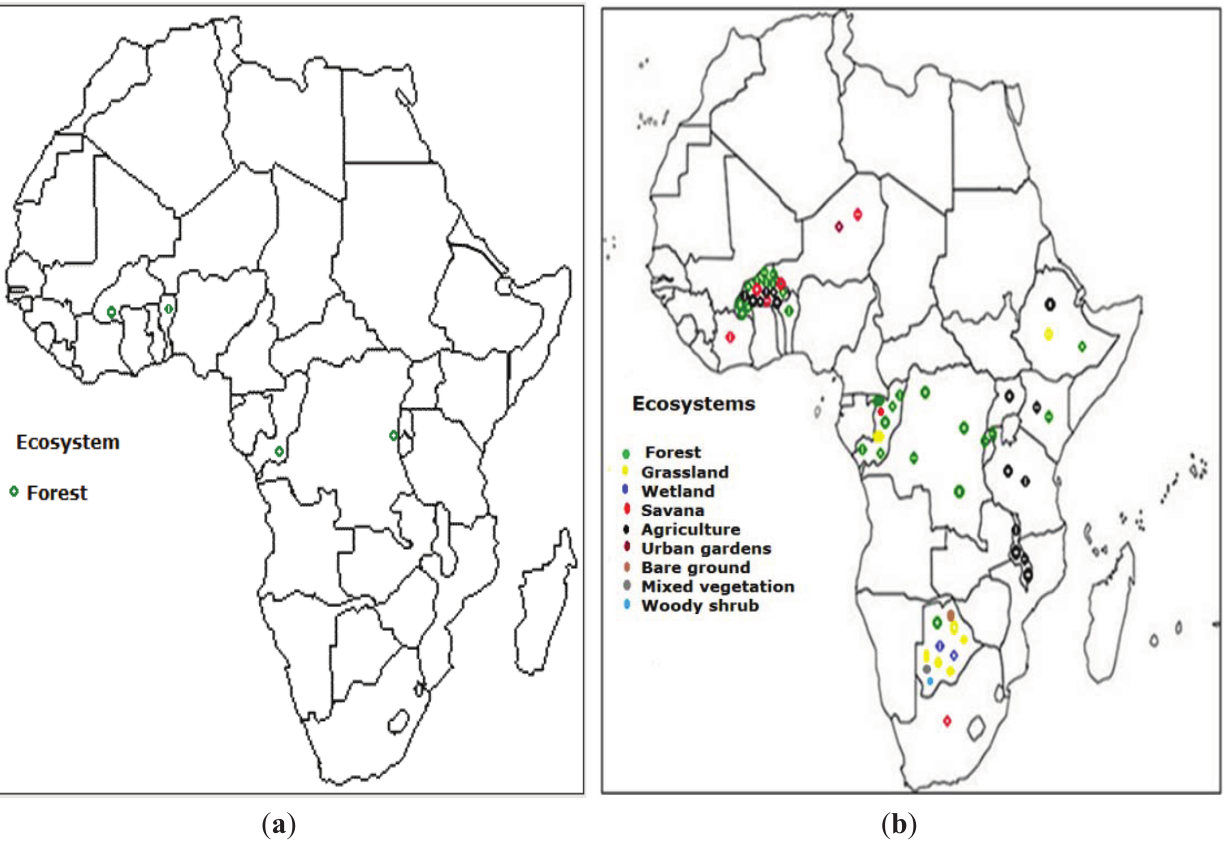
Figure 1. The evolution and spatial distribution of soil respiration observations for different African countries from ( a ) 4 observations in 2010 to ( b ) 62 observations in 2014 inspired by data collected for this study. The dots represent soil respiration measurements for different ecosystems and have been drawn using Arc Map 10